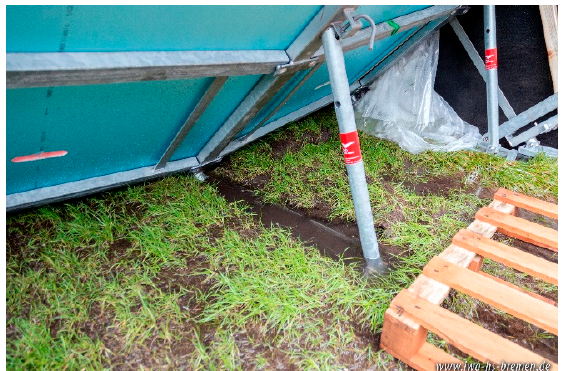
Figure 12. Supporting feet of the aqua defence system sinking into the ground.